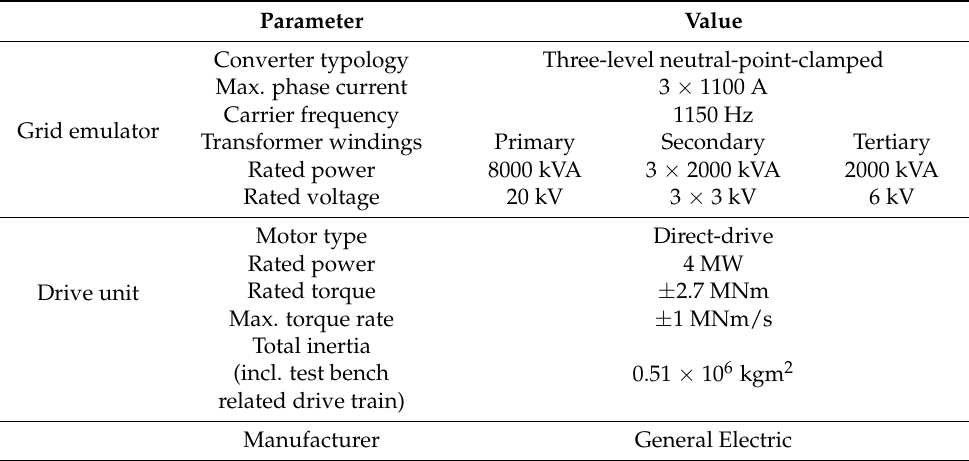
Table 2. Specifications of the test bench’s grid emulator [31] and drive unit.